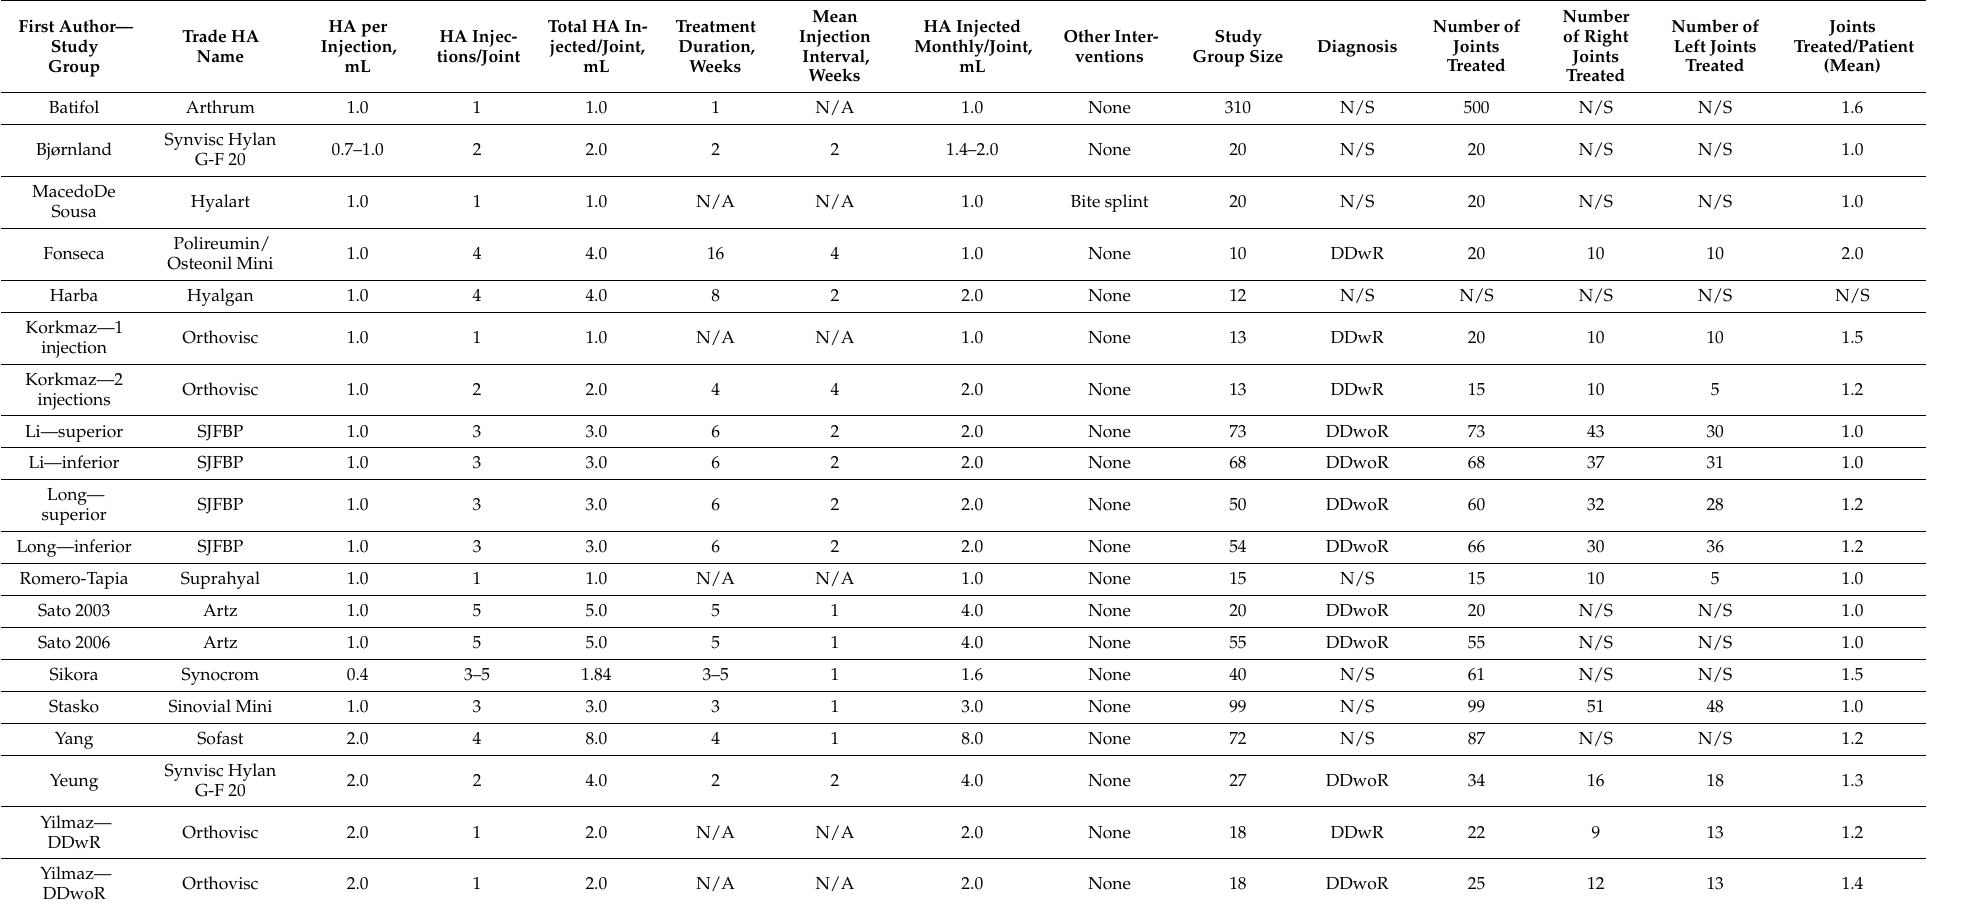
Table 4. Characteristics of the study groups qualified for synthesis. N/A—not applicable; N/S—not specified; DDwR—disk displacement with reduction; DDwoR—disk displacement without